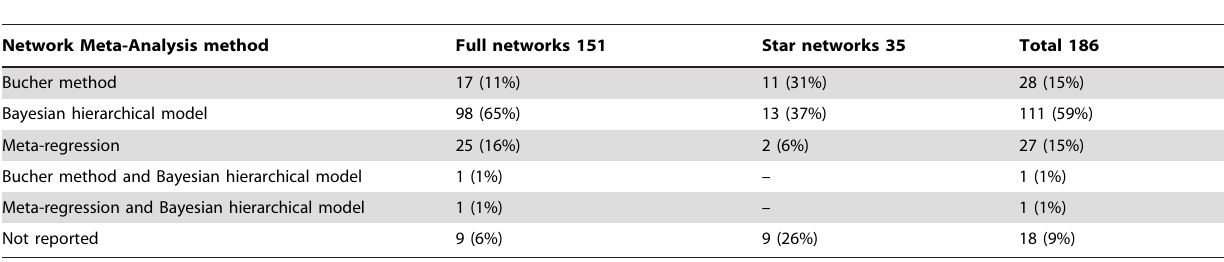
Table 6. Methods employed to synthesise data in full and star networks published until